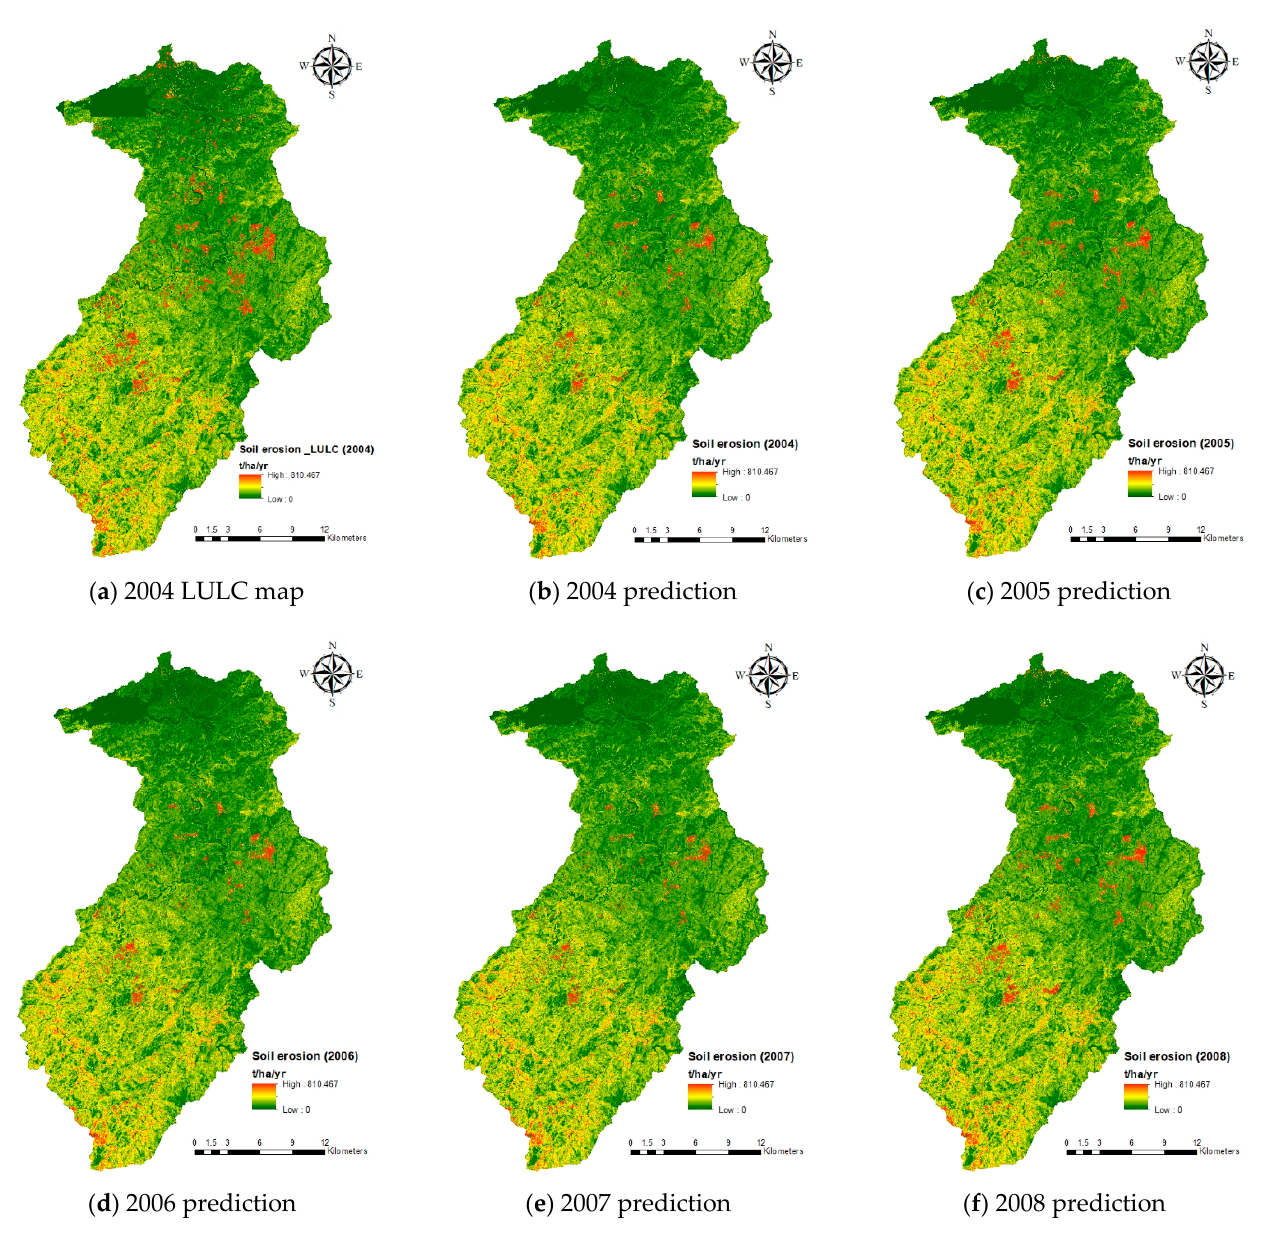
Figure 6. The soil erosion maps of the ( a ) 2004 LULC map, ( b ) 2004 prediction, ( c ) 2005 prediction, ( d ) 2006 prediction, ( e ) 2007 prediction, and ( f ) 2008 prediction (2% sampling rate of the majority class). Table 10. The estimation of annual soil loss based on C-factors of different years (4% and 2% sam- pling rates).